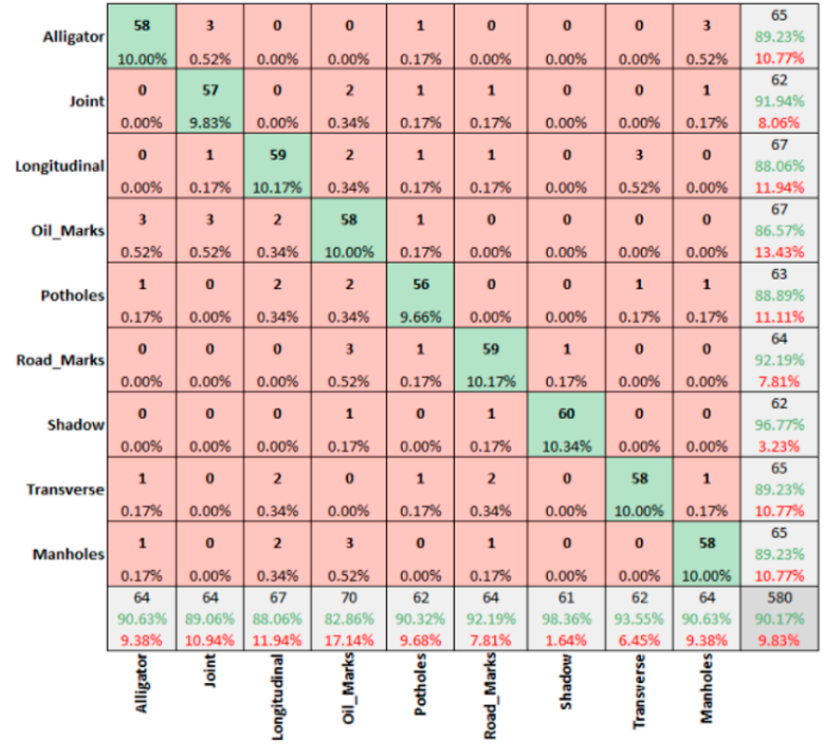
Figure 10. Winter sunny condition—IR-T images.